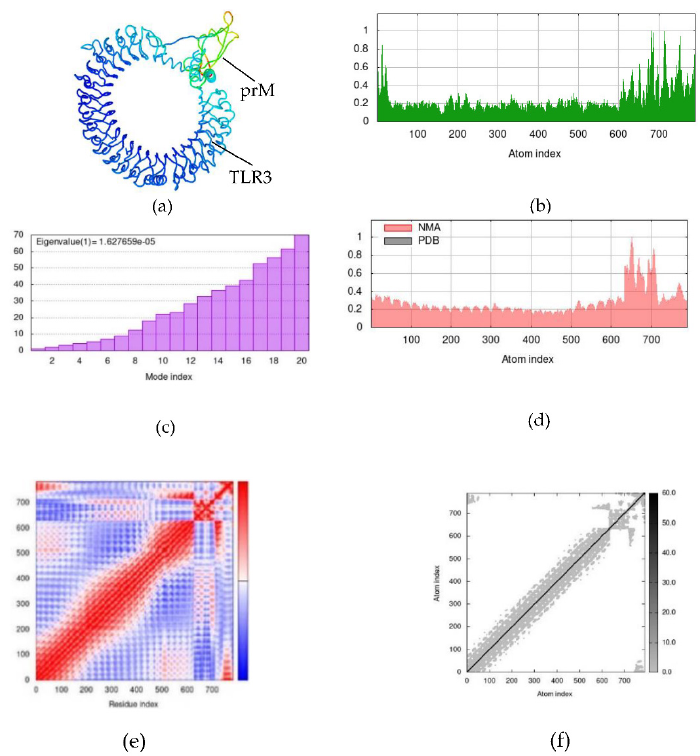
Figure 8. Normal mode analysis (NMA) of prM–TLR3 docking complex by iMODs. ( a ) prM and TLR3 docking complex; ( b ) main-chain deformability; ( c ) the eigenvalue; ( d ) B-factor values; ( e ) covariance map; ( f ) elastic network of model.